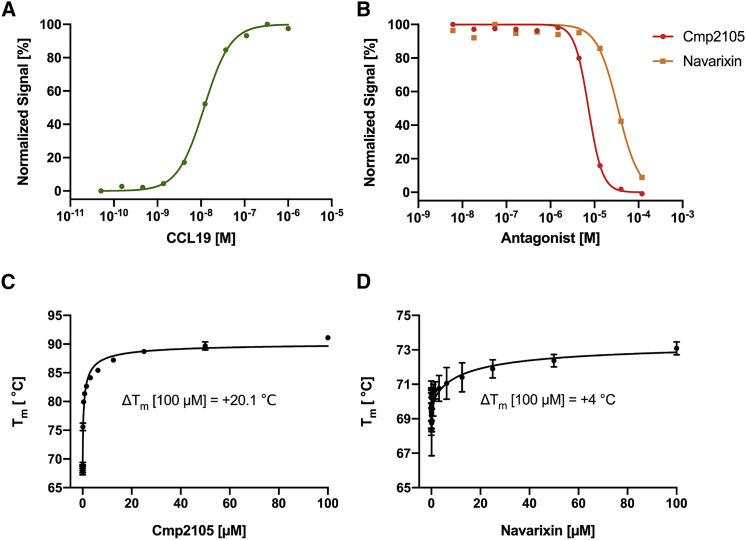
Cellular Arrestin Recruitment Assay and Dose Response Thermofluor Assay(A) Dose response curves with the native agonist CCL19 (green, circles) show arrestin binding with a half effective concentration (EC50) of 0.012 μM.(B) Addition of the allosteric inhibitor Cmp2105 (red, circles) or Navarixin (orange, squares) suppresses arrestin binding in response to activation by CCL19 with half inhibitory concentrations (IC50) of 7.3 μM and 33.9 μM respectively. Data points are the mean of two independent measurements and are normalized to the maximal response.(C) Dose-dependent thermo-stabilizing effect of Cmp2105 on CCR7. Results from 3 independent experiemnts with 3 measurements each (mean ± SEM) were fitted to extract the maximal stabilizing effect and half effective concentration of 0.48 uM for Cmp2105.(D) Dose-dependent thermo-stabilizing effect of Navarixin on CCR7. Results from three independent experiments with three measurements each (mean ± SEM) were fitted to extract the maximal stabilizing effect and half effective concentrations of 13.38 μM for Navarixin.